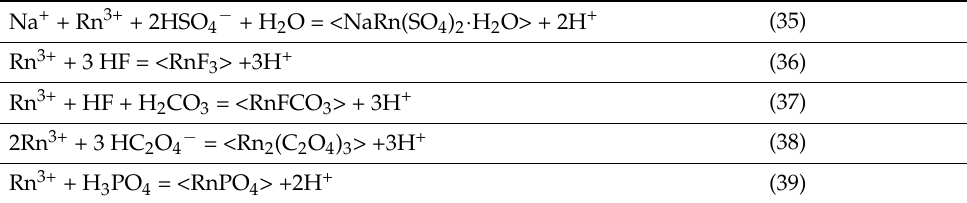
Table 9. Precipitation equations Rn 3+ for precipitation into NaRn(SO 4 ) 2 H 2 O at pH 1 and the results are compared with fluoride, fluoro-carbonate, oxalate, and phosphate (equations used in Figure